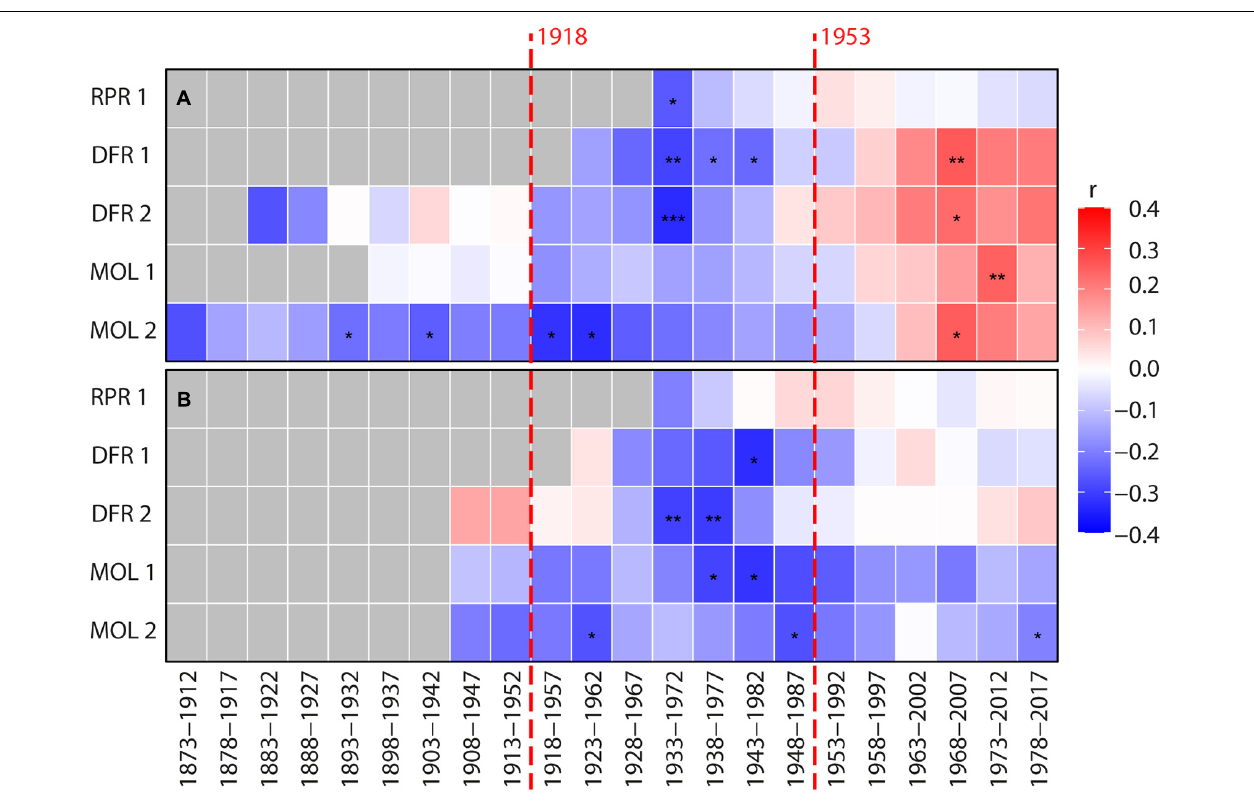
FIGURE 6 | Bootstrapped moving Pearson correlations between individual site ring-width chronologies (A) Harricana River spring (April 15–June 30; 1869–2017) discharge, and (B) the CRU TS 4.04 mean spring precipitation (MAR-APR-MAY-JUN; 1901–2017). The mean spring discharge of the Harricana River used in this analysis is constructed from the reconstructed (1869–1914) and instrumental (1915–2017) series. Pearson correlation coefficients were calculated by 40-year moving windows lagged backward by 5 years and range from red (positive correlation) to blue (negative correlation). Gray color indicates no data. Asterisks in (A,B) panels indicate p -value < 0.1 (*), < 0.05 (*), and < 0.01 (***). Vertical red dashed lines indicate dates of construction of the first and second Monteith